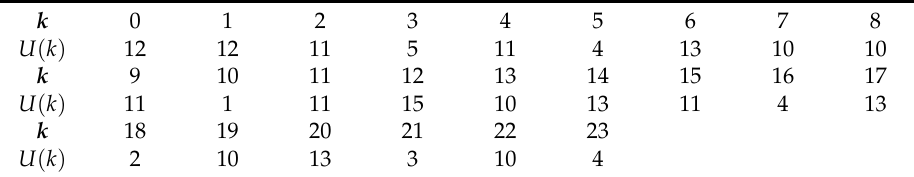
Table 7. Optimal production plan yielded by the random search method.